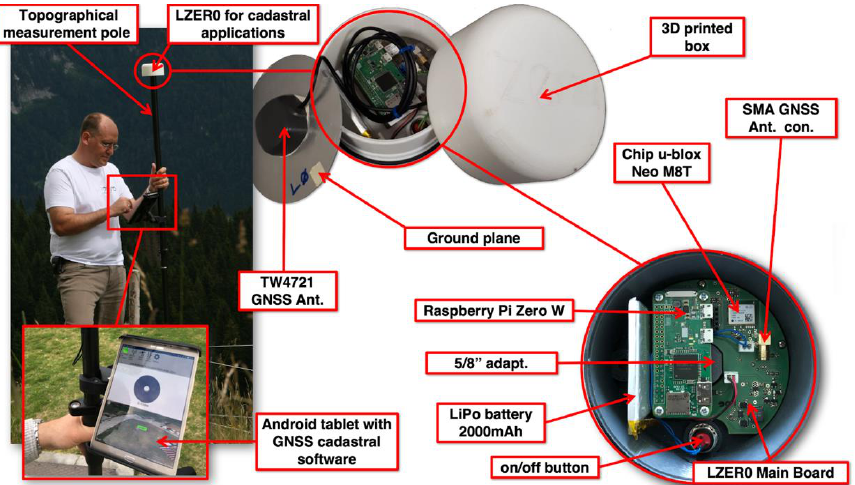
Figure 3. Cadastral LZER0 is a small device designed for surveying or cadastral applications, consisting of the LZER0 motherboard (with the Neo M8T single-frequency chipset), a LiPo battery to power the motherboard (the motherboard can charge the battery via an external USB power supply), and the TW4721 single-frequency GNSS antenna (with an aluminum ground plane). All electronics are included in the 3D-printed case. LZER0 communicates via Wi-Fi connection with an external handheld device (an Android tablet), which is used to track and record the points and trajectories generated by LZER0 in